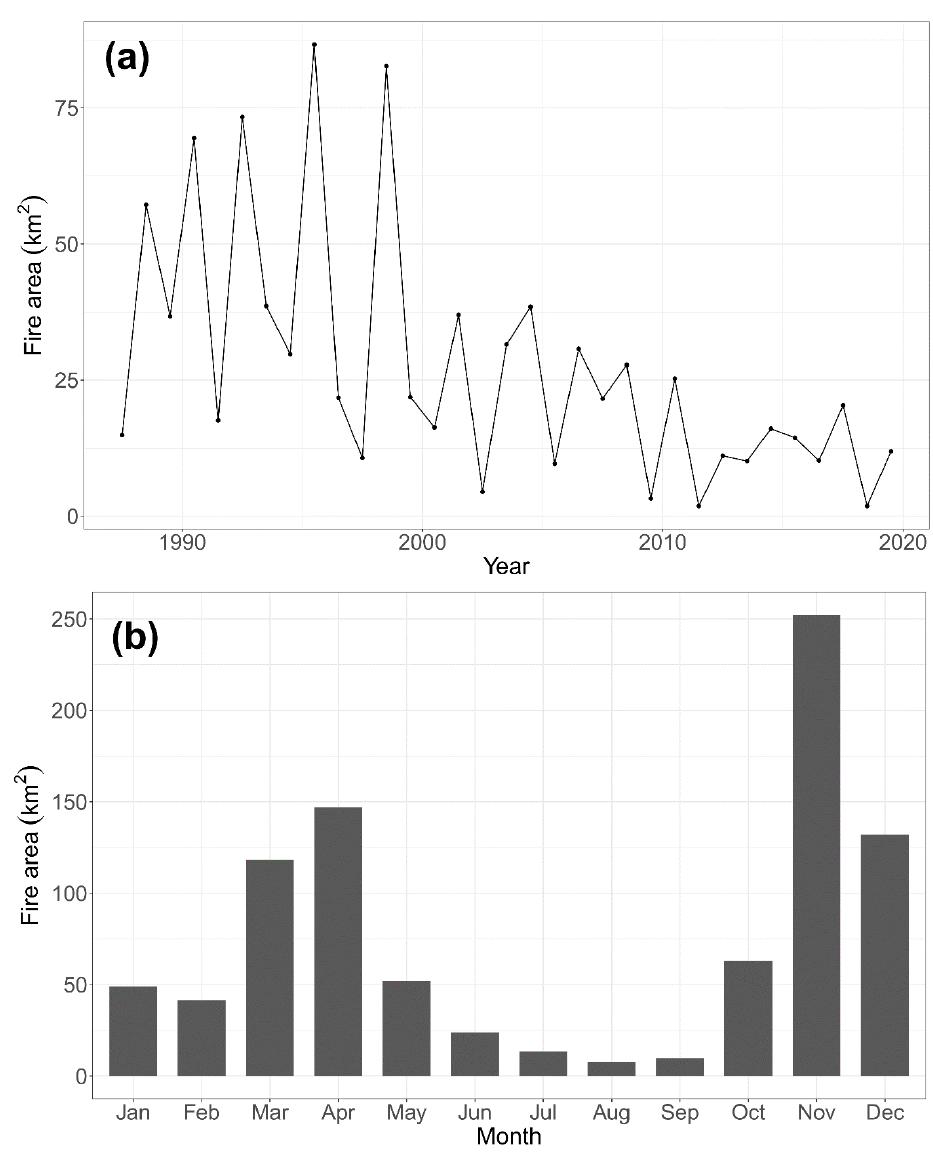
Figure 10. Fire prevalence in Hong Kong over time. ( a ) The burnt area detected by LTS fire in 33 fire seasons (15th July – 15th July of the next calendar year). ( b ) The burnt area detected by LTS fire in each calendar month over the entire study period. Note that there might be a delay between the fire and patch detection.